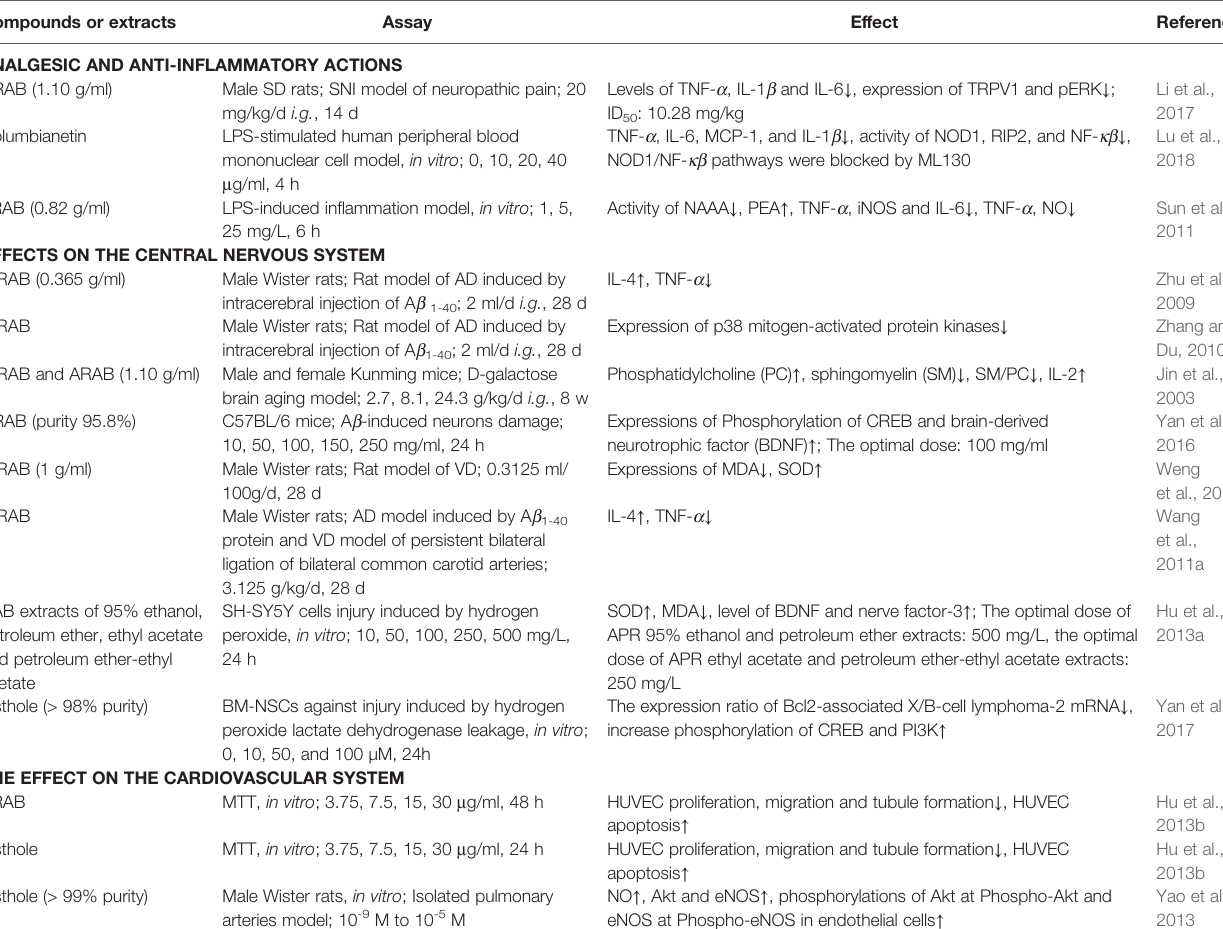
TABLE 4 | The pharmacological activities of APR extracts or certain